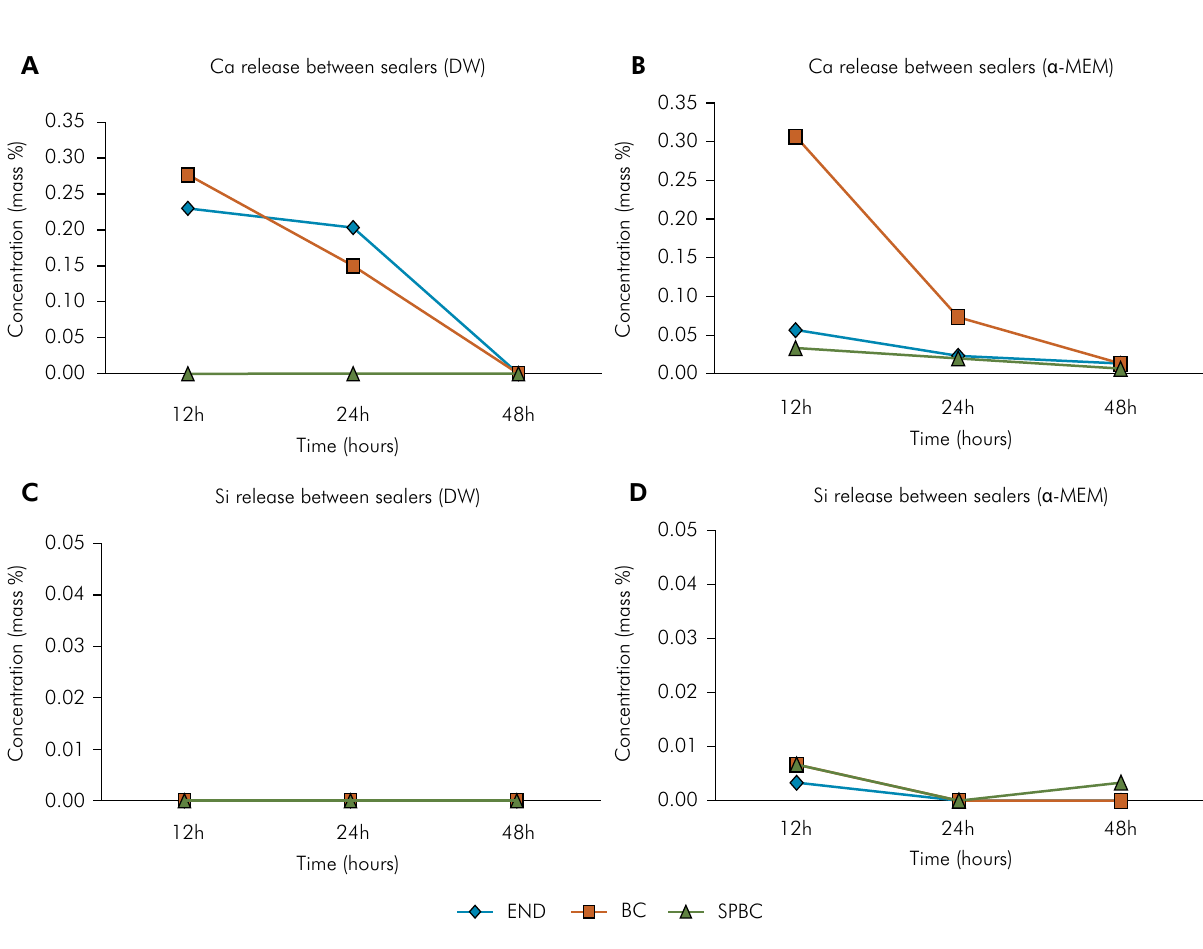
Figure 2. Concentration of ion release among the calcium silicate-based sealers for each soaking solution at the experimental time periods. (A) Calcium release after immersion in DW; (B) calcium release after immersion in α -MEM; (C) silicon release after immersion in DW; and (D) silicon release after immersion in α